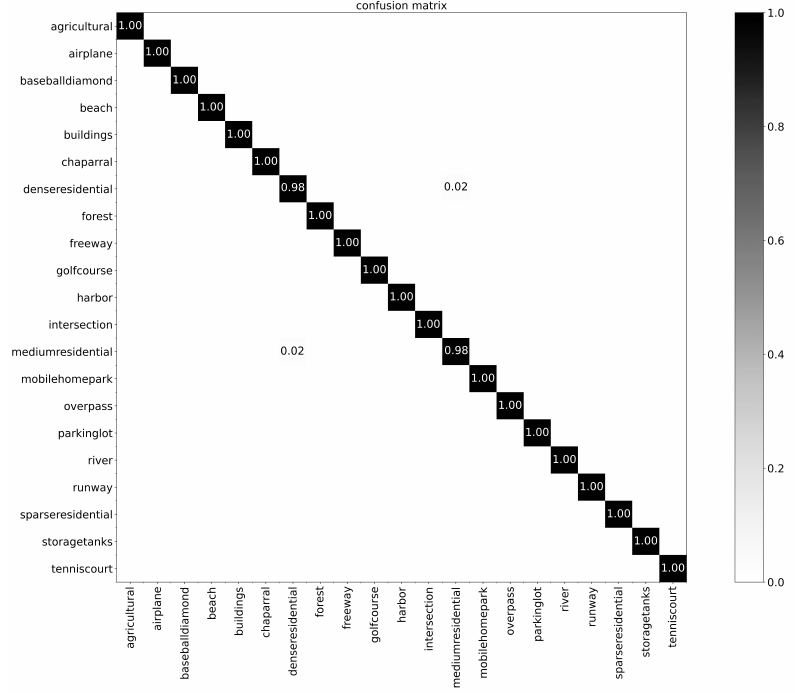
Figure 12. Confusion matrix of our model on UCM dataset.